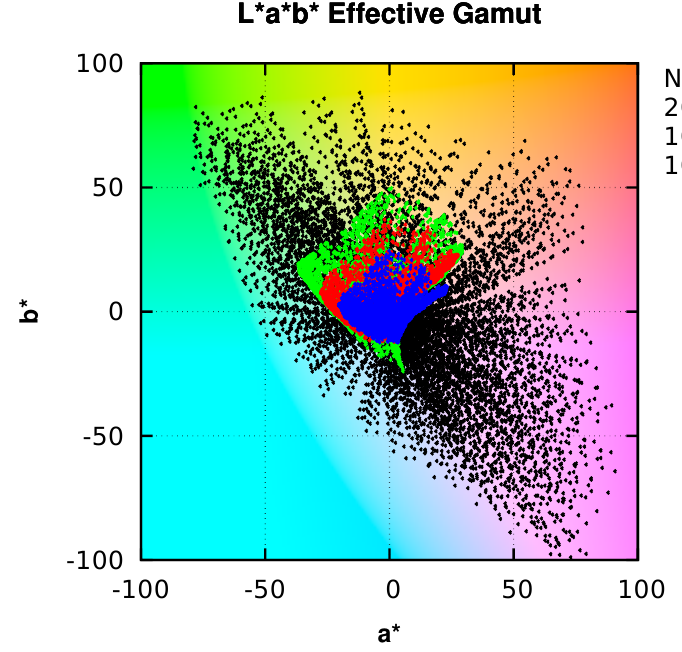
Figure 6. Scatter plots of effective nominal (black) vs. printed (red, green, blue) colours in projected L*a*b* space. The background colours are representative and for orientation